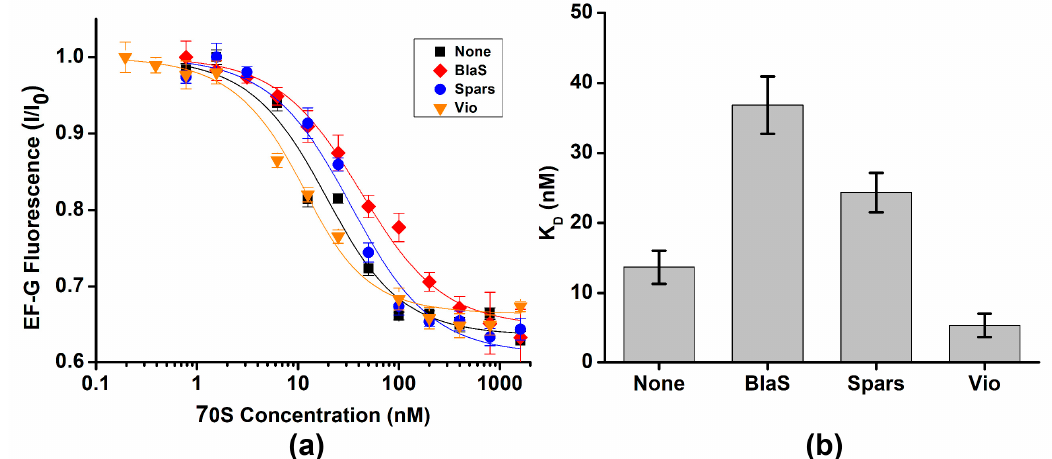
Figure 4. Antibiotics known to perturb the NR ↔ R equilibrium mildly affect EF-G binding. ( a ) EF-G fluorescence (I) normalized to fluorescence observed in the absence of the ribosome (I 0 ) was measured with increasing concentrations of ribosome complexes containing P-site tRNA Phe in the presence of 200 µM blasticidin S (BlaS, red), 40 µM sparsomycin (Spars, blue), 500 µM viomycin (Vio, orange) or in the absence of antibiotics (none, black). ( b ) Dissociation constants (K D ) of EF-G binding determined in the presence or absence of antibiotics. Table 1. E ff ects of P-site tRNA deacylation and antibiotics on dissociation constants (K D ) of EF-G binding.